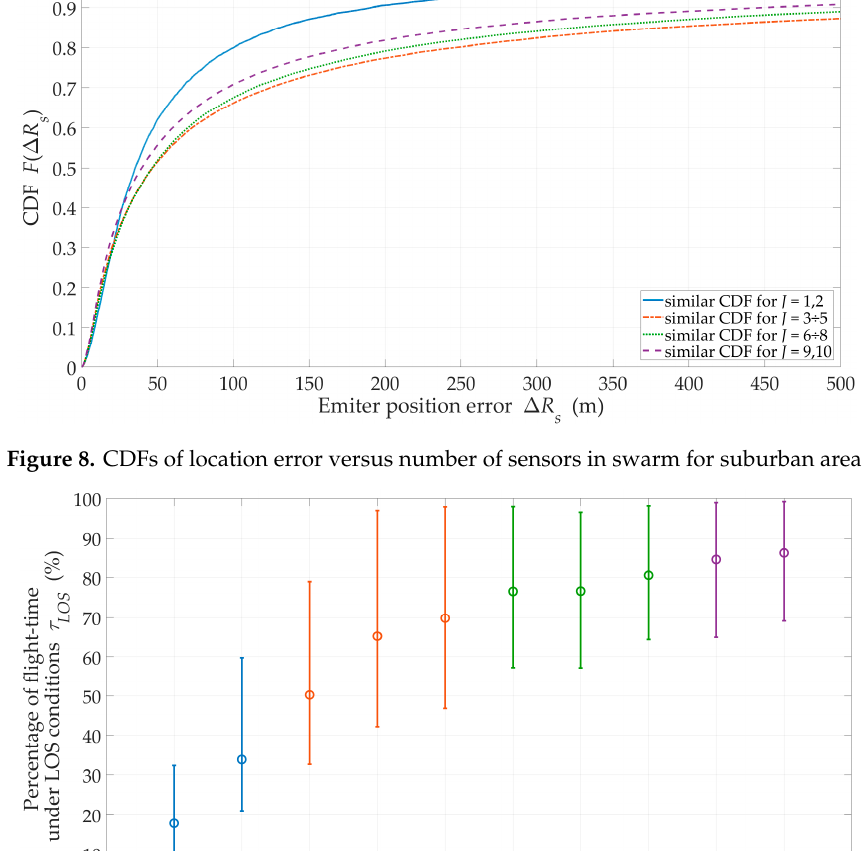
Figure 7. Average location error versus the number of sensors in the swarm for a suburban area.